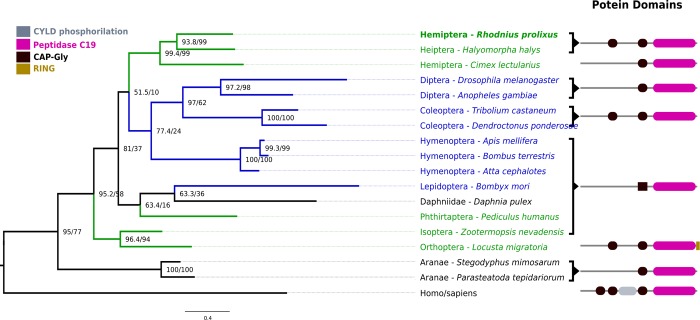
CYLD Maximum likelihood phylogenetic tree in selected arthropods.Hemimetabolous insects are divided among three clades, comprising hemipterans, phthirapterans, and paraneopterans. Most holometabolous insects form a clade that clusters with the hemipteran clade including rpCYLD. The human UBC9 was used as outgroup to build the ML trees.